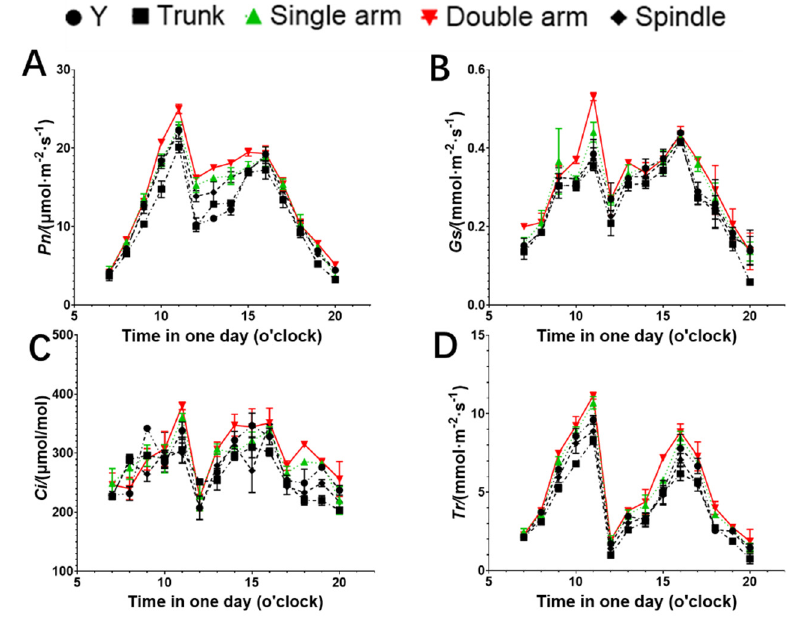
Figure 3. The effects of different tree shapes on the Pn ( A ), Gs ( B ), Ci ( C ), and Tr ( D ). The error bars represent the standard deviation (SD).